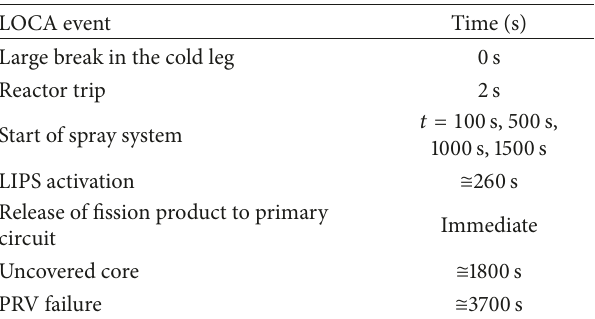
Figure 3: A schematic diagram of a typical PWR system with the containment spray system.